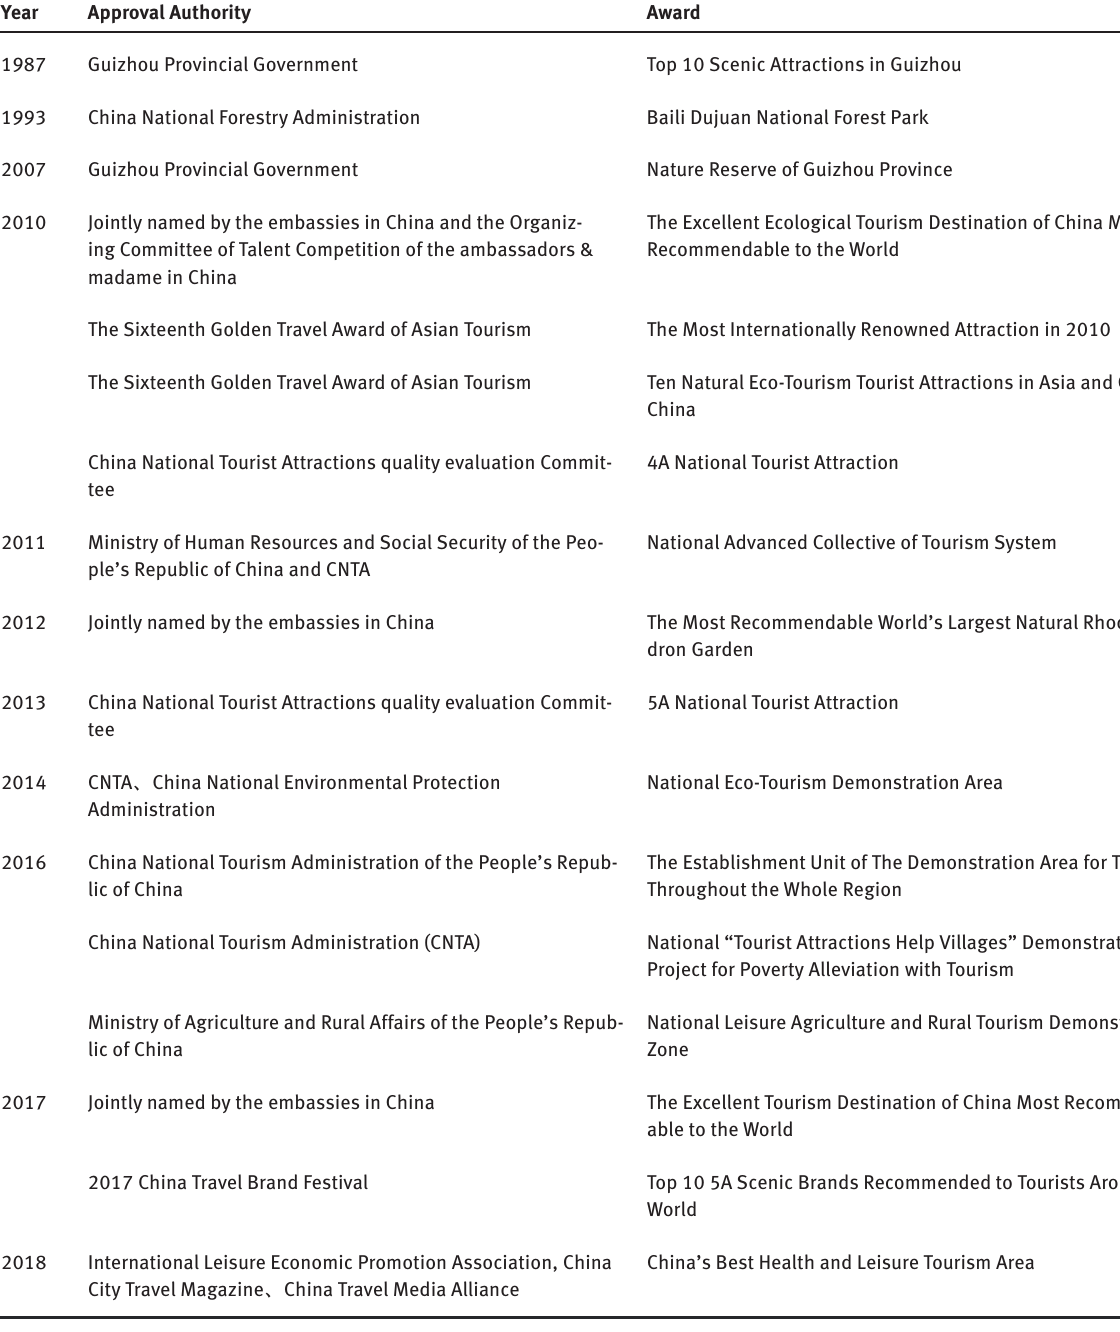
Table 1: Timeline of Beili Dujuan Scenic Area development (Source: Baili Rhododendron Administration Tourism Bureau,